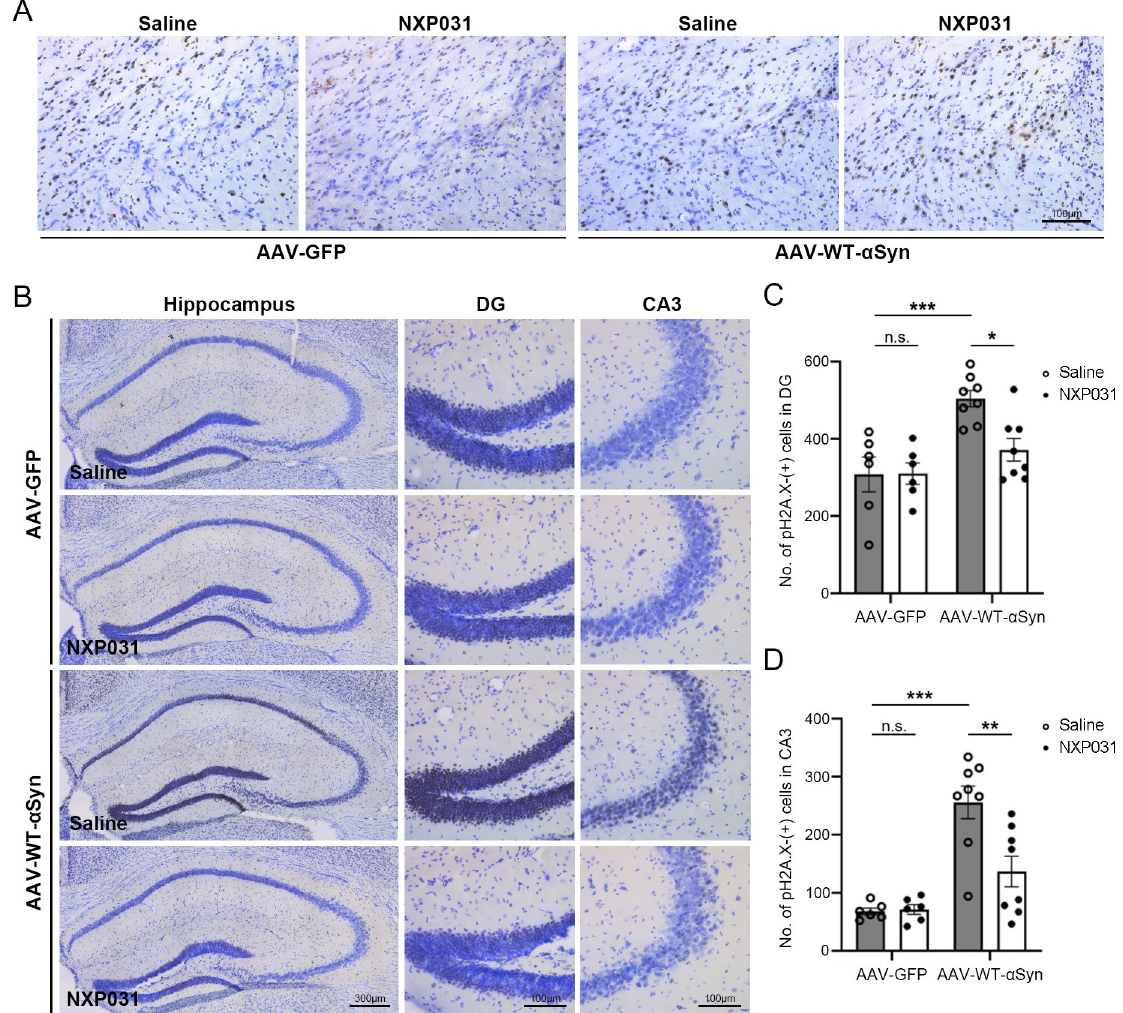
Fig 5. Effect of NXP031 on DNA damage in the hippocampus of mice after delivery of GFP-only or α -Syn AAV. (A) Representative micrographs of γ H2A.X immunostaining in the SN. (B) Representative micrographs of γ H2A.X immunostaining in the hippocampus. (C) The number of γ H2A.X positive cells in the hippocampal DG. (D) The number of γ H2A.X positive cells in the hippocampal CA3. Data are presented as the mean ± S.E.M. (Two-way ANOVA followed by Tukey’s test, � p < 0.05, �� p < 0.01, ��� p < 0.001 compared to selected group, n = 6–8 mice per